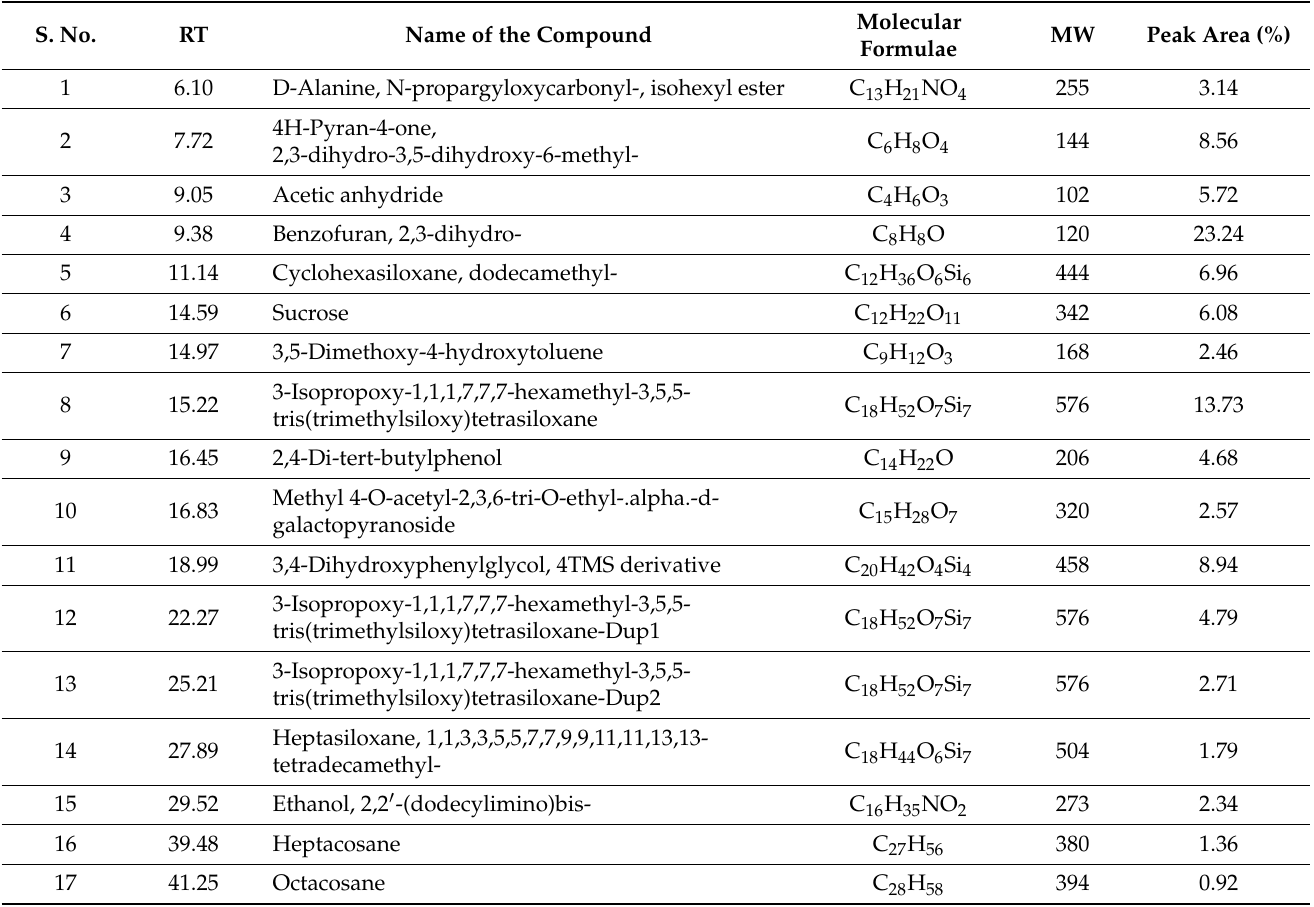
Table 4. Compounds identified in water-extracted C. tinctorius .